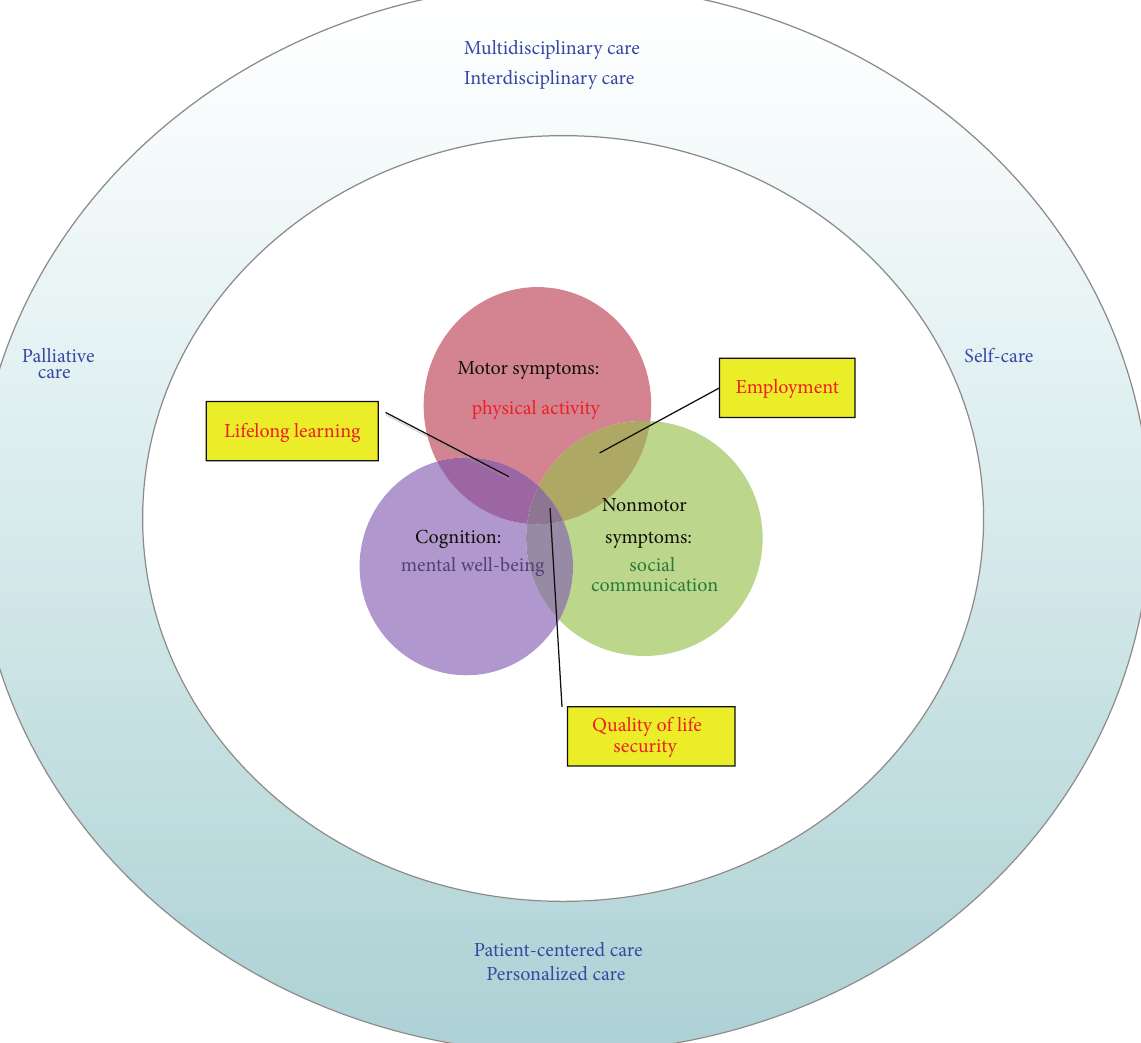
Figure 1: The schematic view of the platform to show how the symptoms of Parkinson’s disease influence corresponding components of active aging, potential consequences (yellow boxes), and the proposed modifying caring approaches (surrounding blue circle) for adaptation.